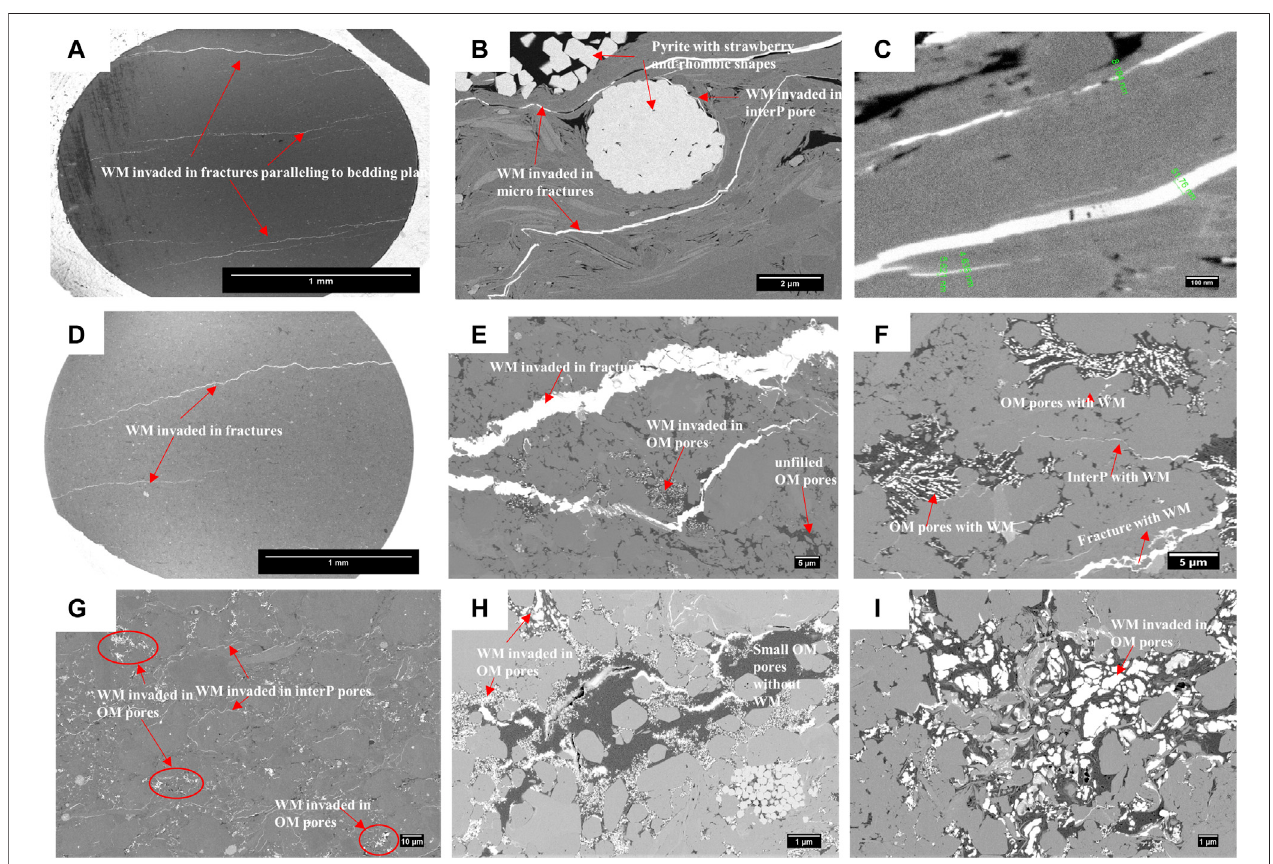
FIGURE 7 | SEM images of the three shale samples investigated after WM injection. (A – C) Images of the argillaceous shale sample (sample SW-1) showing that WMintrudedmainlyinfracturesalongbeddingplaneswithfewinclaymatrixpores. (D – F) ImagesofsampleJY9,massivesiliceousshaleormudstone,showingthatWM intruded in both fractures and matrix pores including OM pores and interpores adjacent to fractures. (G – I) Images of sample WY23-6-6, the laminar mixed shale, showing that WM intruded in most of matrix pores including OM pores and interP pores.